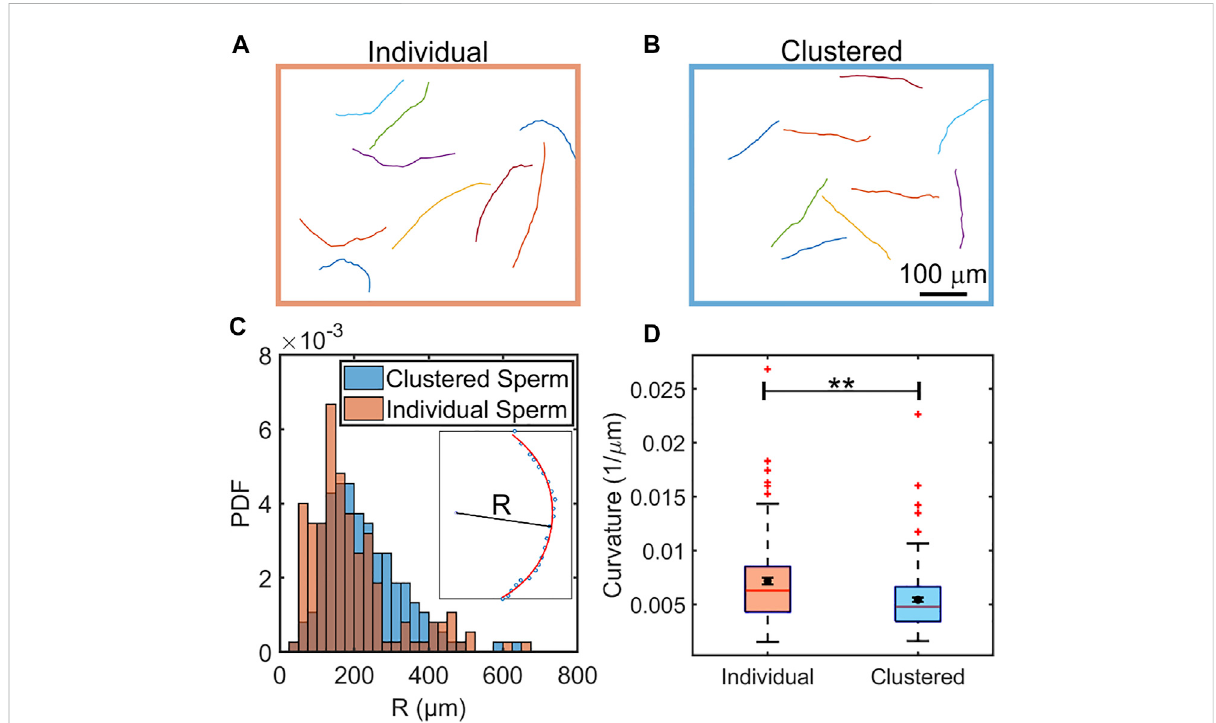
FIGURE 2 Comparisonofswimmingtrajectoriesofindividual (A) andclustered (B) spermintheabsenceof fl ow.N=9sampletrajectories,eachsampledat 6.67 Hz and for 3.60 s. The distributions of radii of curvature of clustered (blue) and individual (orange) sperm from 150 trajectories each (C) . Inset: Calculation of the R was performed by fi tting a trajectory to a partial circle using MATLAB. (D) , Box plot comparison of curvature of individual and clustered sperm. The means are shown by a black dot. The box plot shows the median, 25%, and 75% quartiles; whiskers show the smallest and largest data within 1.5 interquartile ranges below 25% and above 75% quartiles respectively; data beyond the whiskers are outliers and shown by +. N = 150 trajectories each sampled at 6.67 Hz and for 3.60 s. Error bars represent standard errors of the mean (SEM) and ** indicates p <